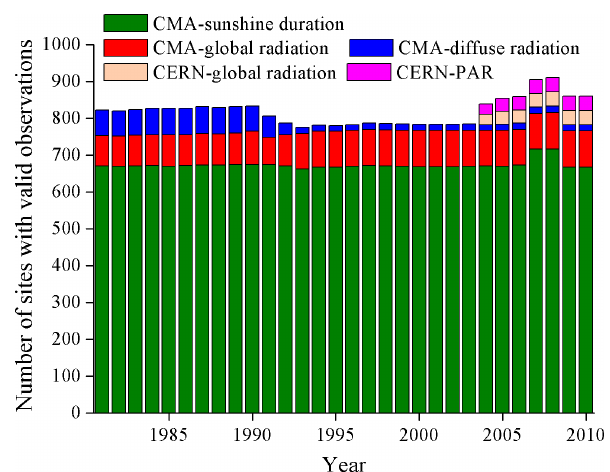
Figure 3. The numbers of sites with valid observational data of sunshine duration, global radiation, diffuse radiation, and photosyn- thetically active radiation (PAR) per year from 1981 to 2010. CMA and CERN represent the China Meteorology Administration and the Chinese Ecosystem Research Network,